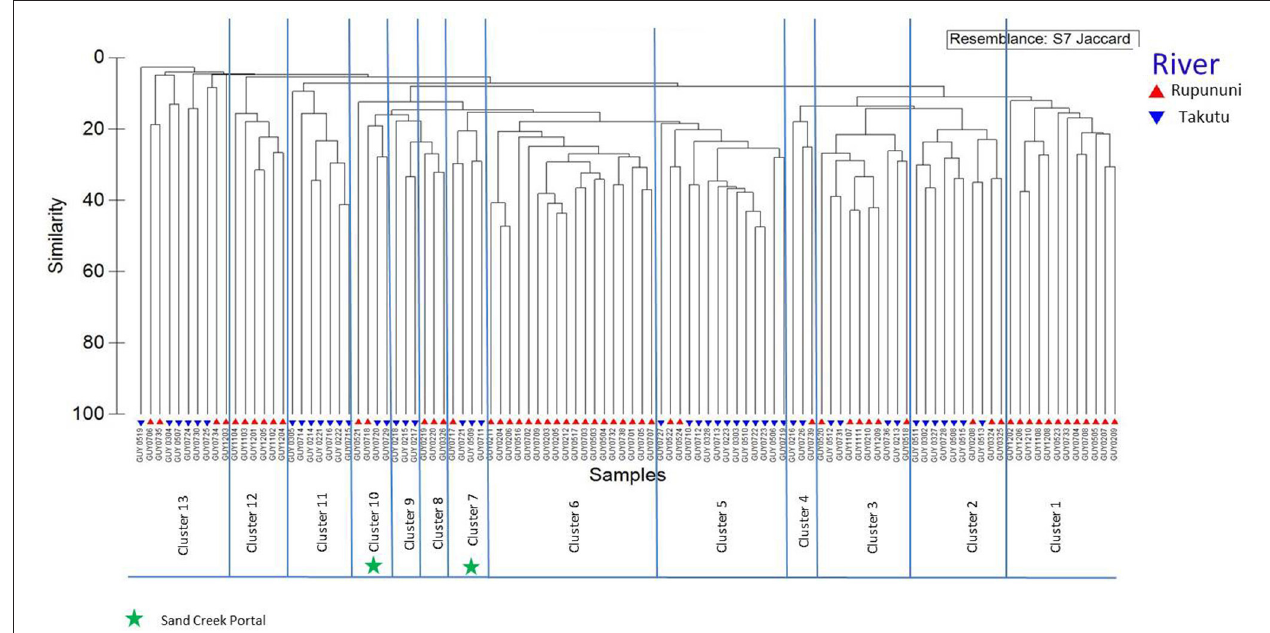
FIGURE 2 | Dendrogram of Rupununi (58 sites) and Takutu River (46 sites) species assemblage relationships derived from cluster analysis (based on Jaccard’s similarity matrix). Mixed clusters between the Takutu and Rupununi represent areas with similar species compositions and potential interconnectedness of the two rivers. These mixed clusters include known areas of mixing through the Rupununi Portal (i.e., Cluster 13). Clusters represented by green stars are evidence for connectedness through the proposed Sand Creek Portal in the South